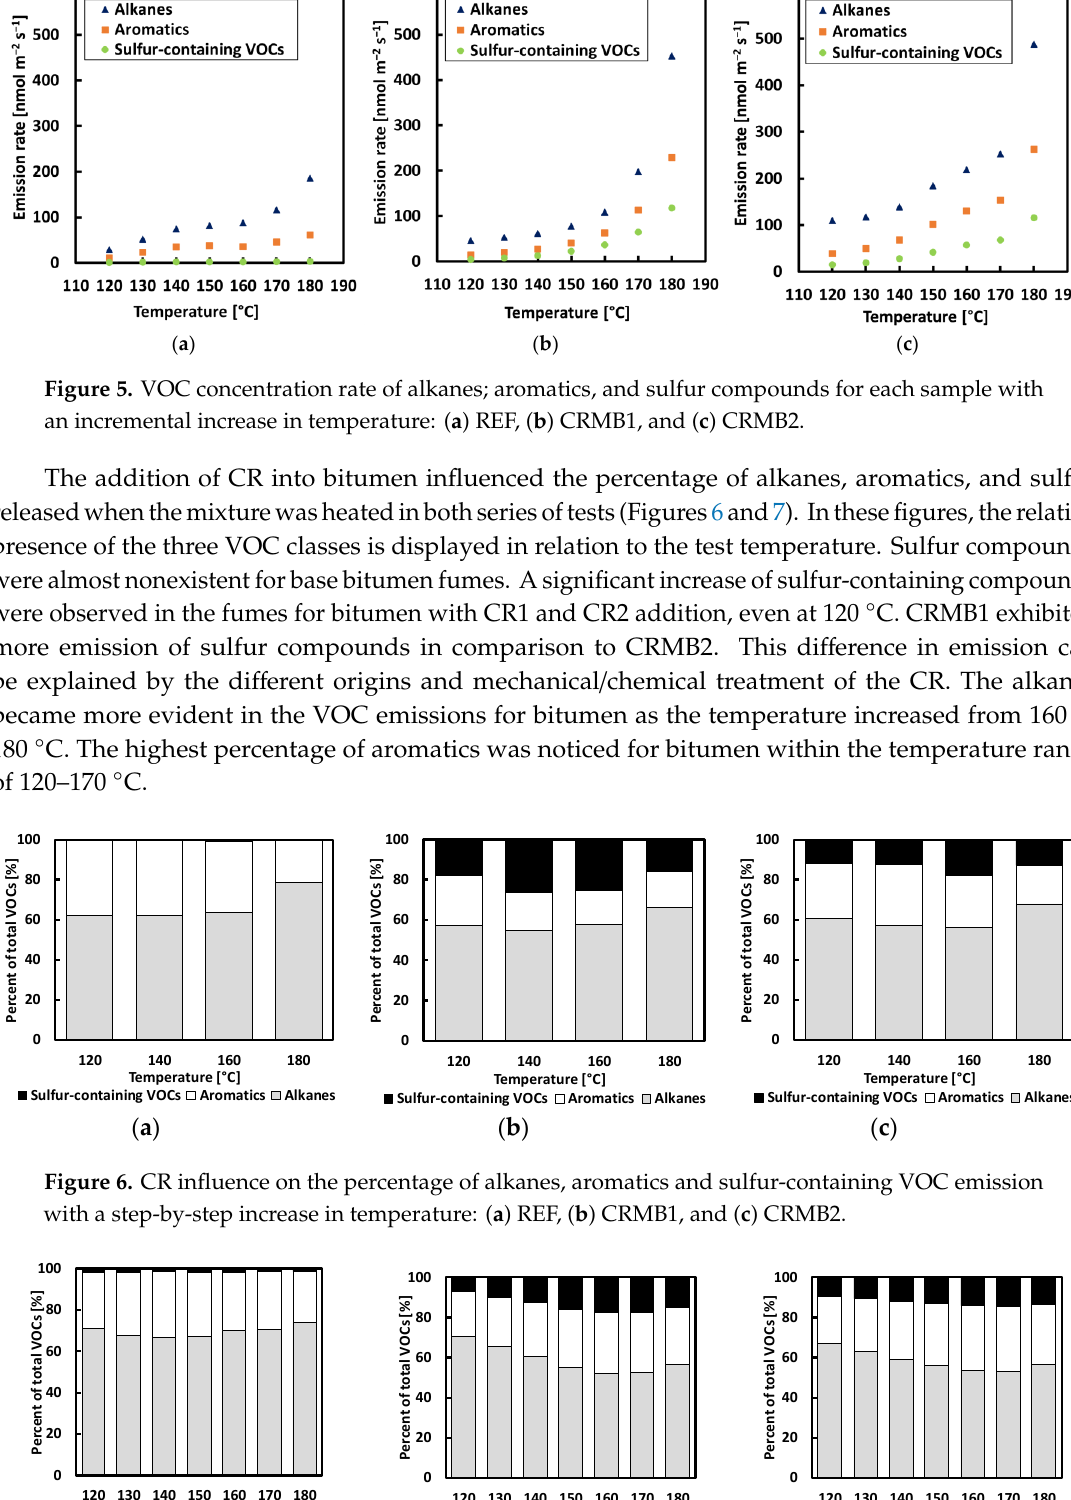
Figure 4. VOC concentration rate of alkanes, aromatics, and sulfur compounds for each sample with a step-by-step increase in temperature: ( a ) REF, ( b ) crumb rubber modified bitumen 1 (CRMB1), and ( c ) CRMB2.